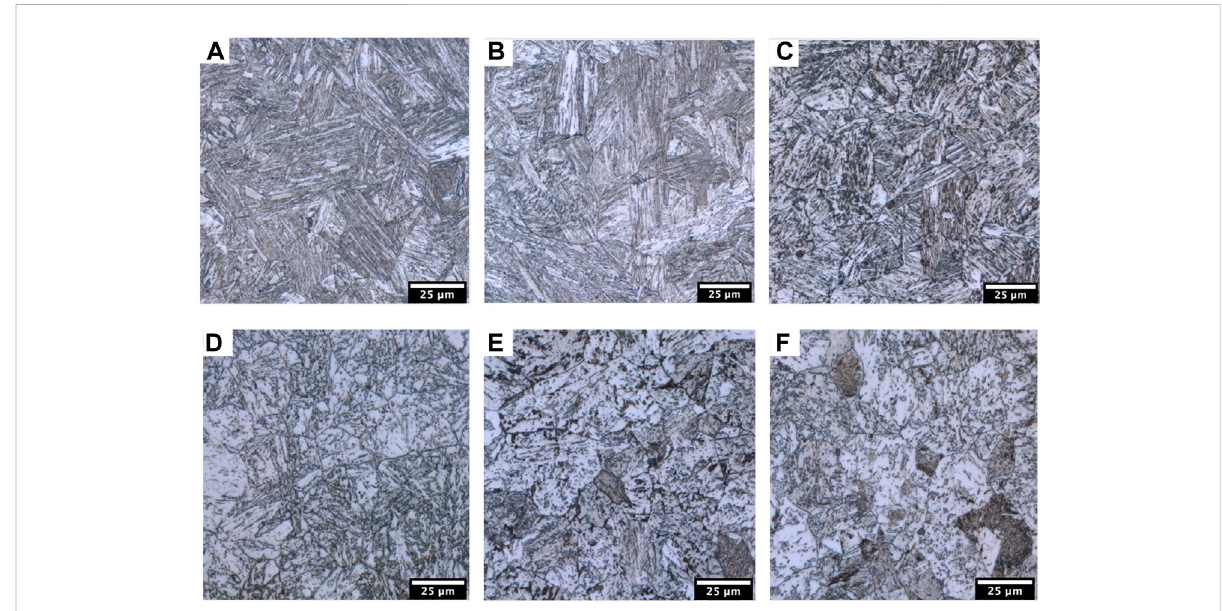
FIGURE 1 A selection of optical micrographs of representative sections of the used samples. The cooling rates of the quenching are: (A) 3,600 ° C/s, (B) 2,400 ° C/s, (C) 300 ° C/s, (D) 56 ° C/s, (E) 15 ° C/s, (F) 5 ° C/s. The samples shown in (A) and (B) show purely martensitic microstructures and (C — F) show mainly bainitic microstructures. Sample (C) show lath-like bainitic microstructures that show visual similarities to martensitic packages. The bainitic samples (D — F) illustrate the continuously increasing amount of carbon depletion in more distinctive carbon rich